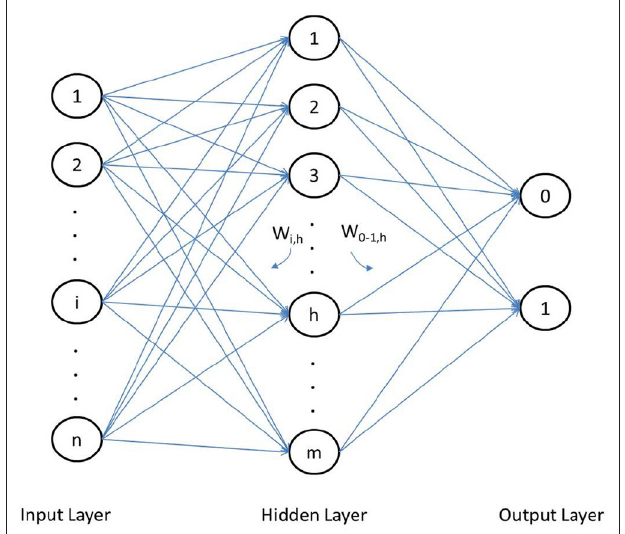
FIGURE 3 | Three-layer multilayer